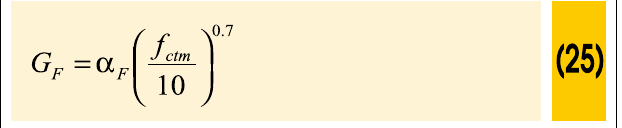
where α is a coefficient that depends on the maximum aggregate F size, also given in table